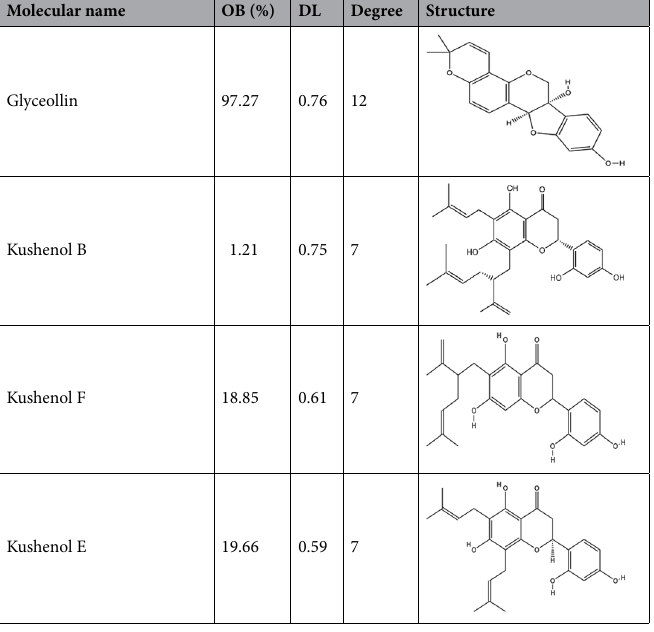
Table 1. Information of bioactive compounds of